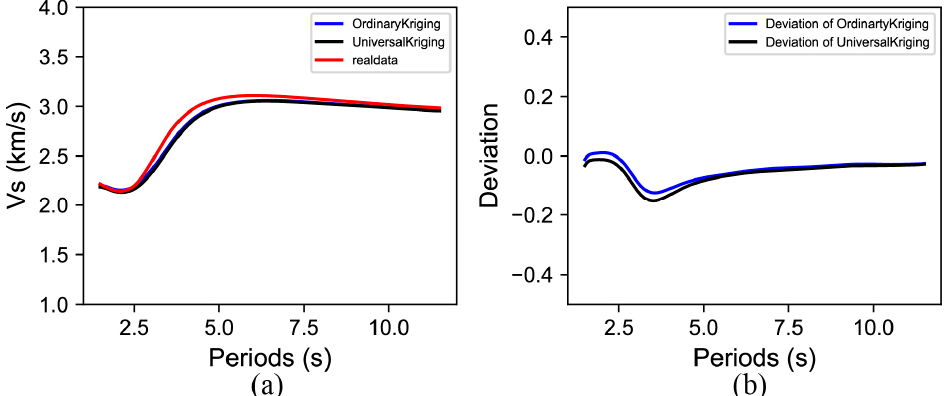
Figure A5. Comparison of dispersion curve interpolation results (128.18° E, 41.76° N ). The blue curve indicates the ordinary kriging results, while the black curve indicates those of universal kriging: ( a ) Comparison of the dispersion curves; and ( b ) deviation of the OK (blue) or UK (black) results.